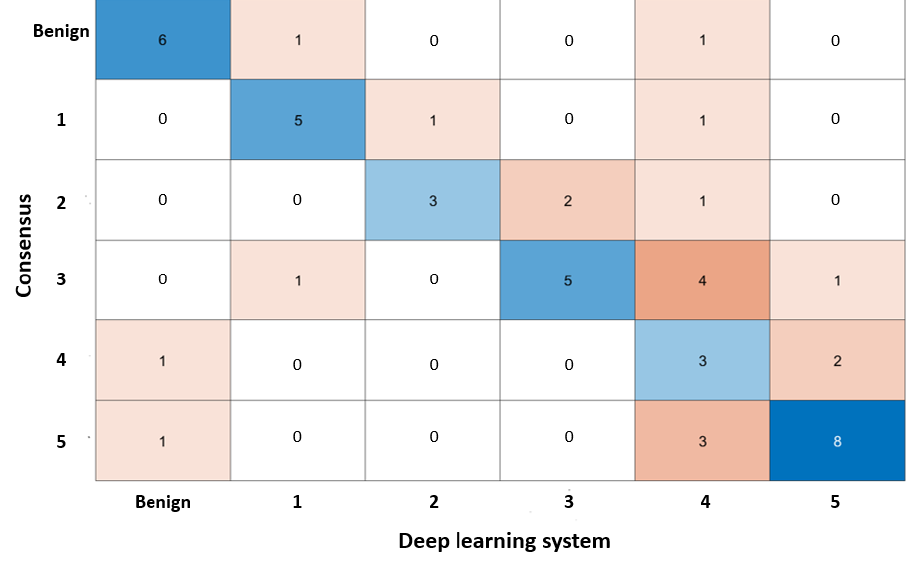
Figure 7. Confusion matrices on grade